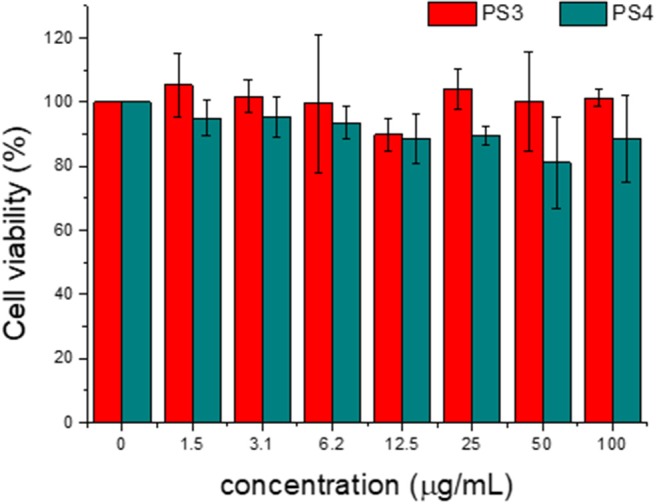
Effect of PS3 and PS4 on MCF-7 cell viability as a function of concentration in incubation medium for 24 h. The percentages refer to cell viability represented as a percentage of control.